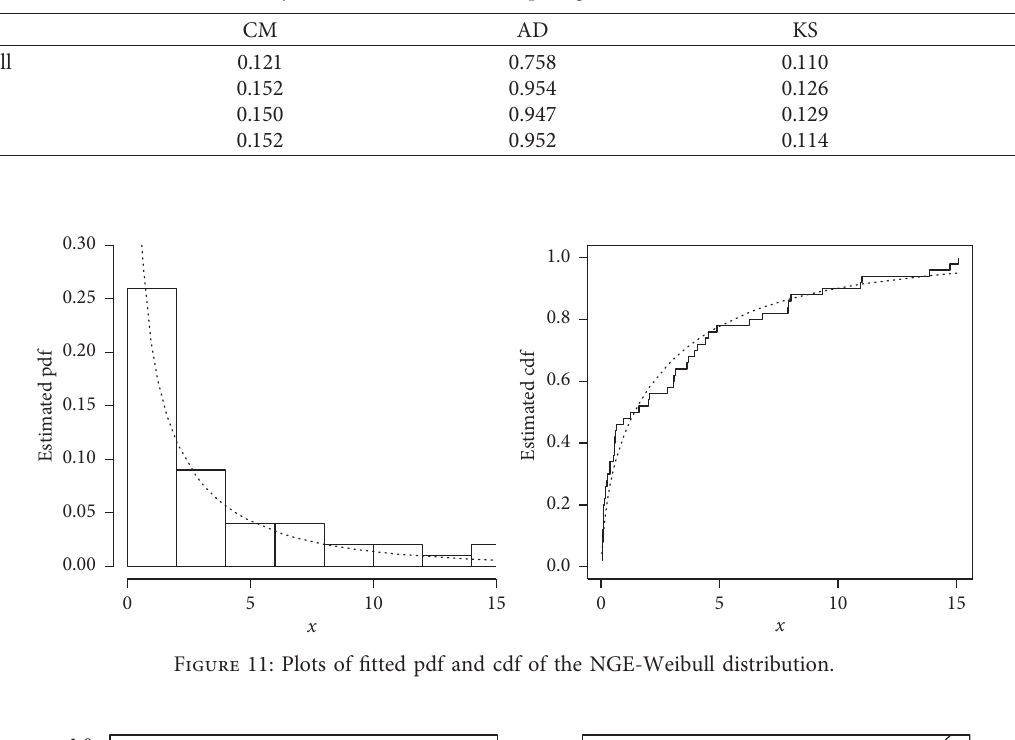
Table 5: The analytical measures of the competing models for the failure time data.